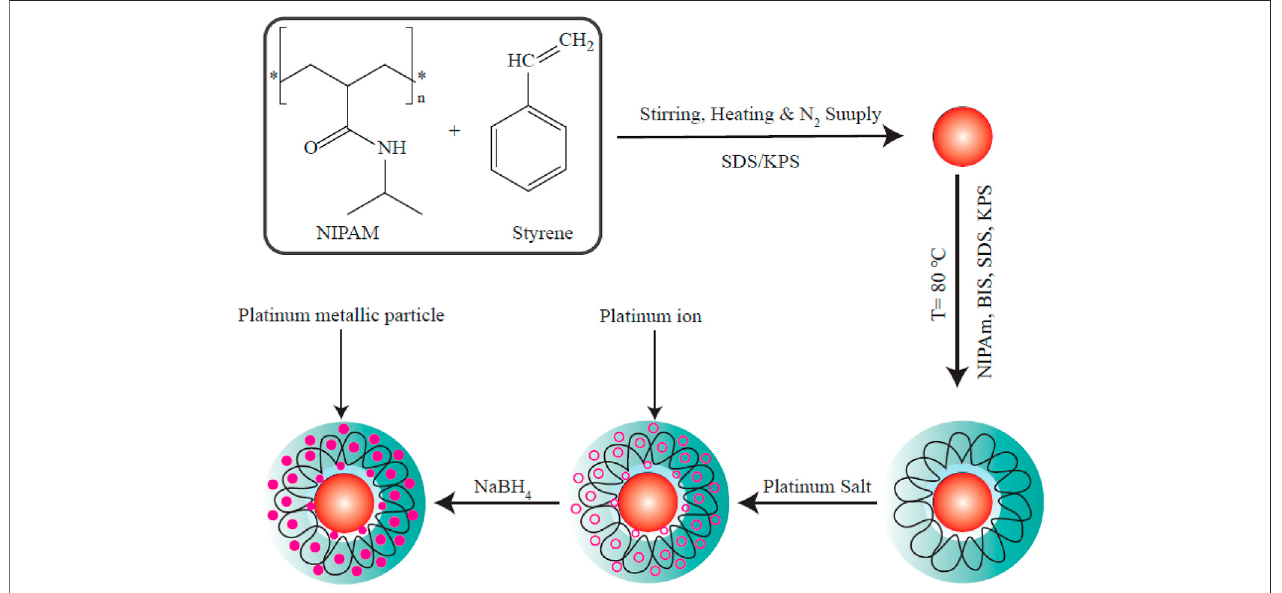
FIGURE 3 | Chemical synthesis of doped platinum